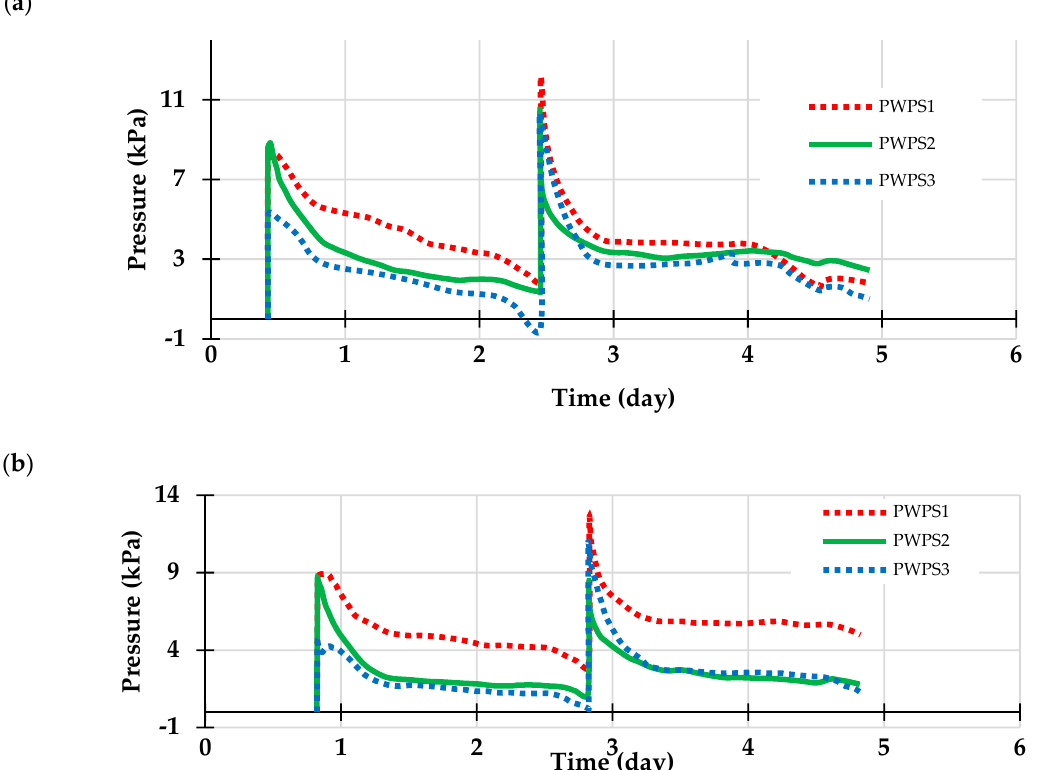
Figure 5. Measurement of pore water pressure of uncemented fill at three locations in the model: ( a ) for the GSD #1 barricade, and ( b ) for the GSD #5 barricade.